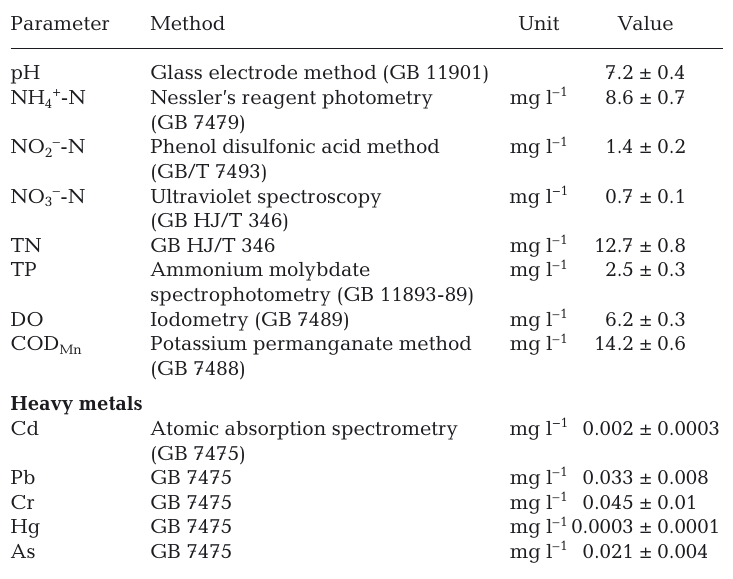
Table 1. Mean (±SD) water-quality parameters, measurement methods used (GB number: relevant Chinese national standard method), and measured